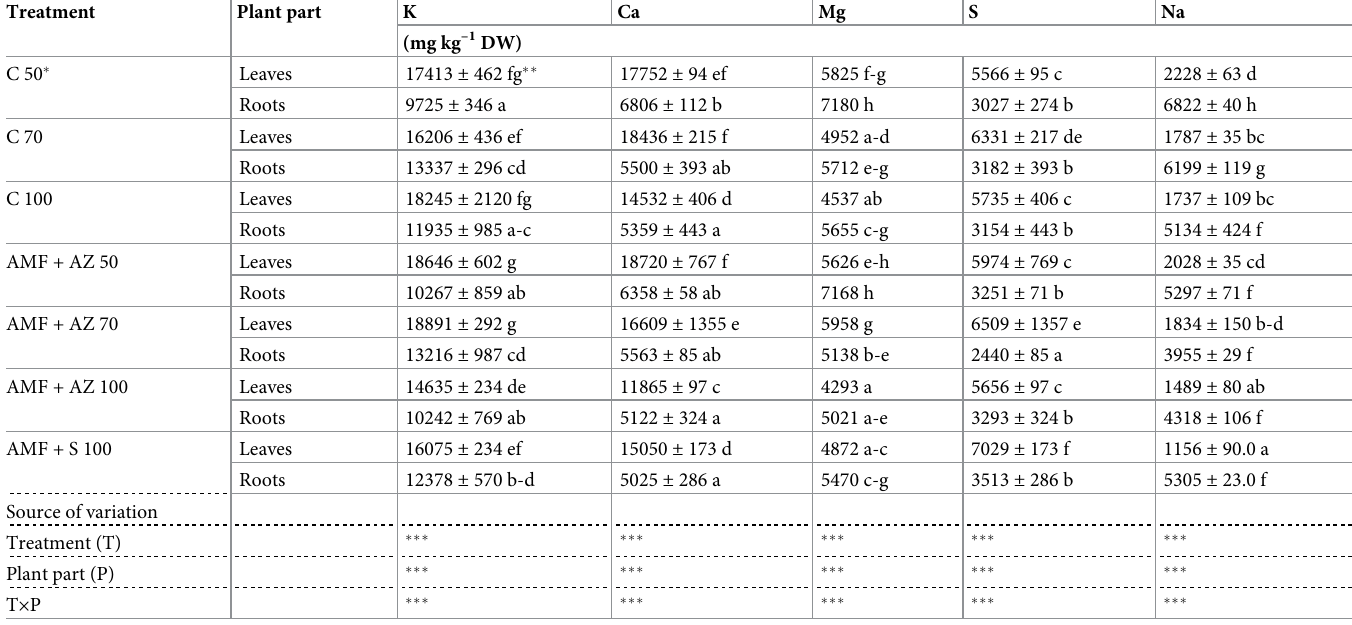
Table 5. Effects of soil microorganisms application to substrates of different organic matter content on potassium, calcium, manganese, sulphur, and sodium con- tent in leaves and roots of tomato transplants.